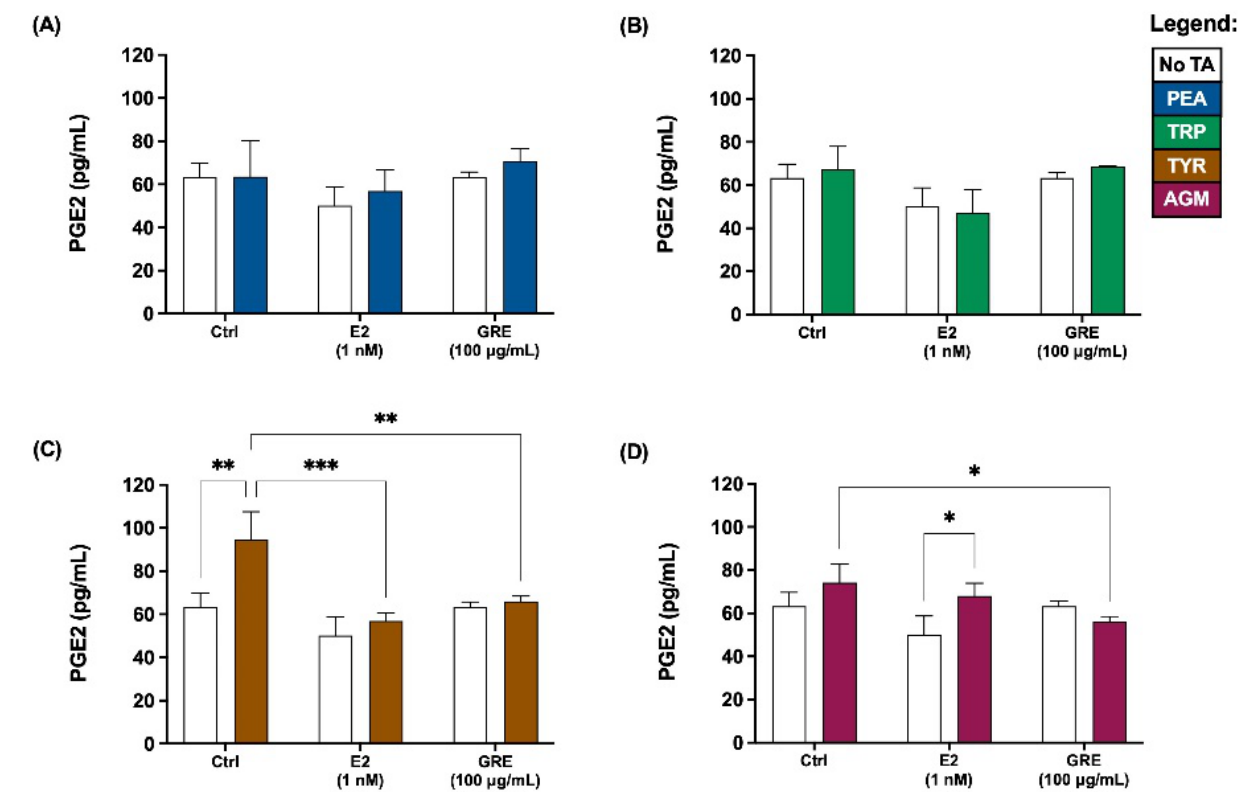
Figure 3. Effects of green rooibos extract (GRE) and 17 β -estradiol (E2) on the concentration of prostaglandin E2 (PGE2) secreted by HT-29 cell monolayers following selected TA-exposure (200 ng/mL): ( A ) β -phenethylamine (PEA), ( B ) tryptamine (TRP), ( C ) ρ -tyramine (TYR) and ( D ) agmatine (AGM). Data are represented at mean ± SD, n = 3. Statistical analysis: 2-way ANOVAs with Tukey’s multiple comparison tests: * = p < 0.05, ** = p < 0.01, *** = p < 0.001.